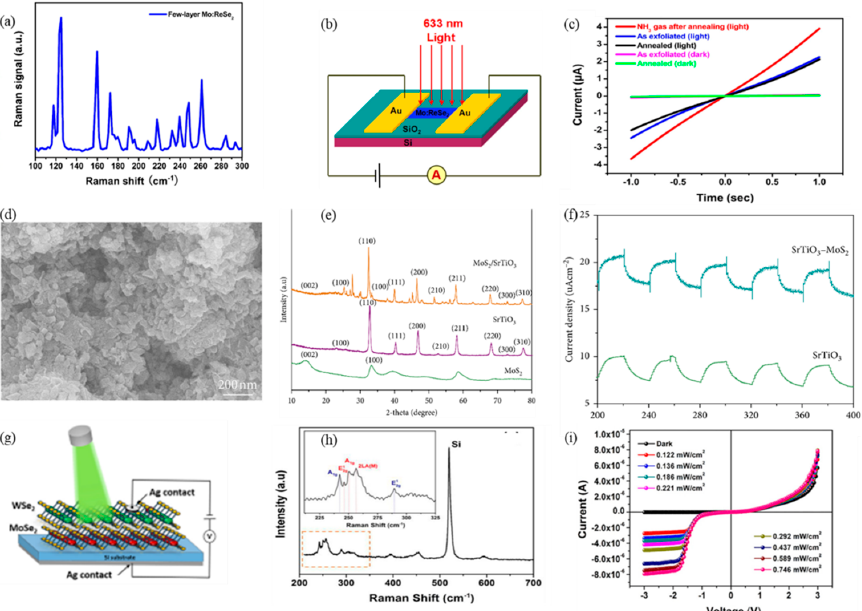
Figure 28. ( a ) Raman spectrum of Mo: ReSe 2 material. ( b ) Experimental schematic diagram of using Mo: ReSe 2 as photodetector. ( c ) Voltammetric characteristic diagram of Mo: ReSe 2 material with different conditions [327]. Copyright 2014 Nature Publishing Group. ( d ) Scanning electron microscope image of SrTiO 3 @ MoS 2 . ( e ) X-ray diffraction images of several materials. ( f ) Comparison chart of current intensity between SrTiO 3 and SrTiO 3 @ MoS 2 [123]. Copyright 2020 Hindawi Publishing Corporation. ( g ) Schematic diagram of the MoSe 2 -WSe 2 structure for light response measurement. ( h ) Raman spectrum of MoSe 2 -WSe 2 . ( i ) Volt-ampere characteristic curve of MoSe 2 -WSe 2 under different light intensity [328]. Copyright 2020 American Chemical Society.